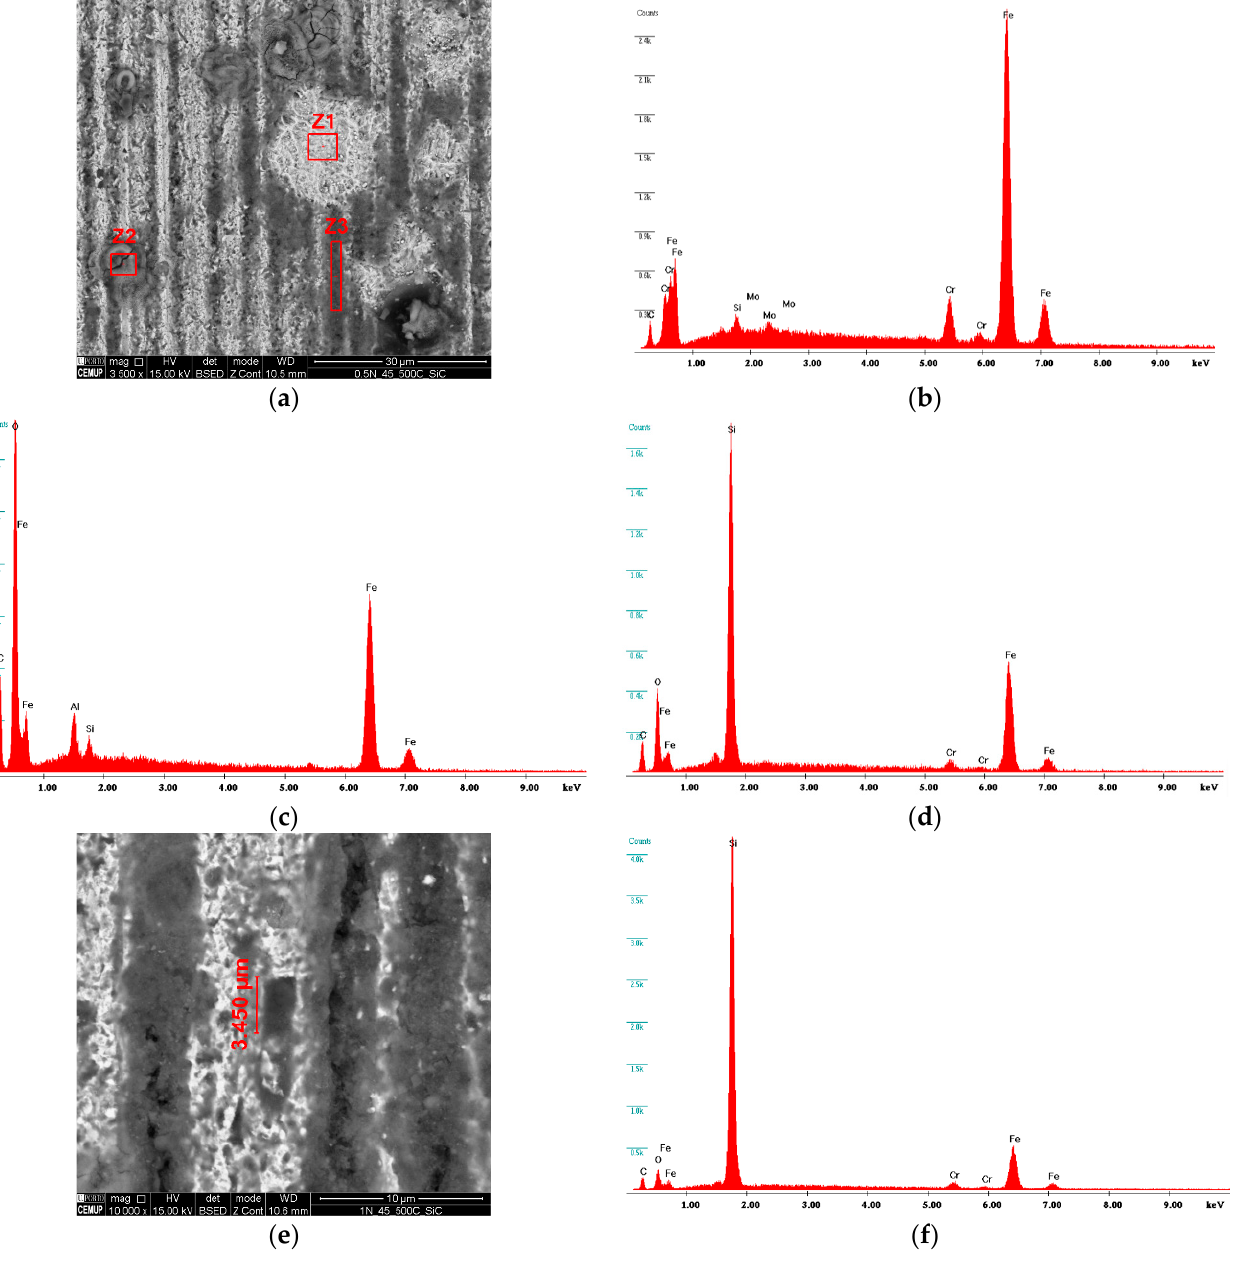
Figure 14. SEM analysis in craters subjected to a load of 0.5 N and SC of 0.45 g/cm 3 : ( a ) identification of the presence of SiC particles and oxidation; ( b ) EDS spectrum in the Z1 zone indicating oxidation release; ( c ) EDS spectrum in the Z2 zone indicating oxidation; and ( d ) EDS spectrum in the Z3 zone indicating deposited SiC Particles; ( e ) groove with aggregated SiC particle; ( f ) EDS spectrum indicating a SiC particle with 3.450 μ m.